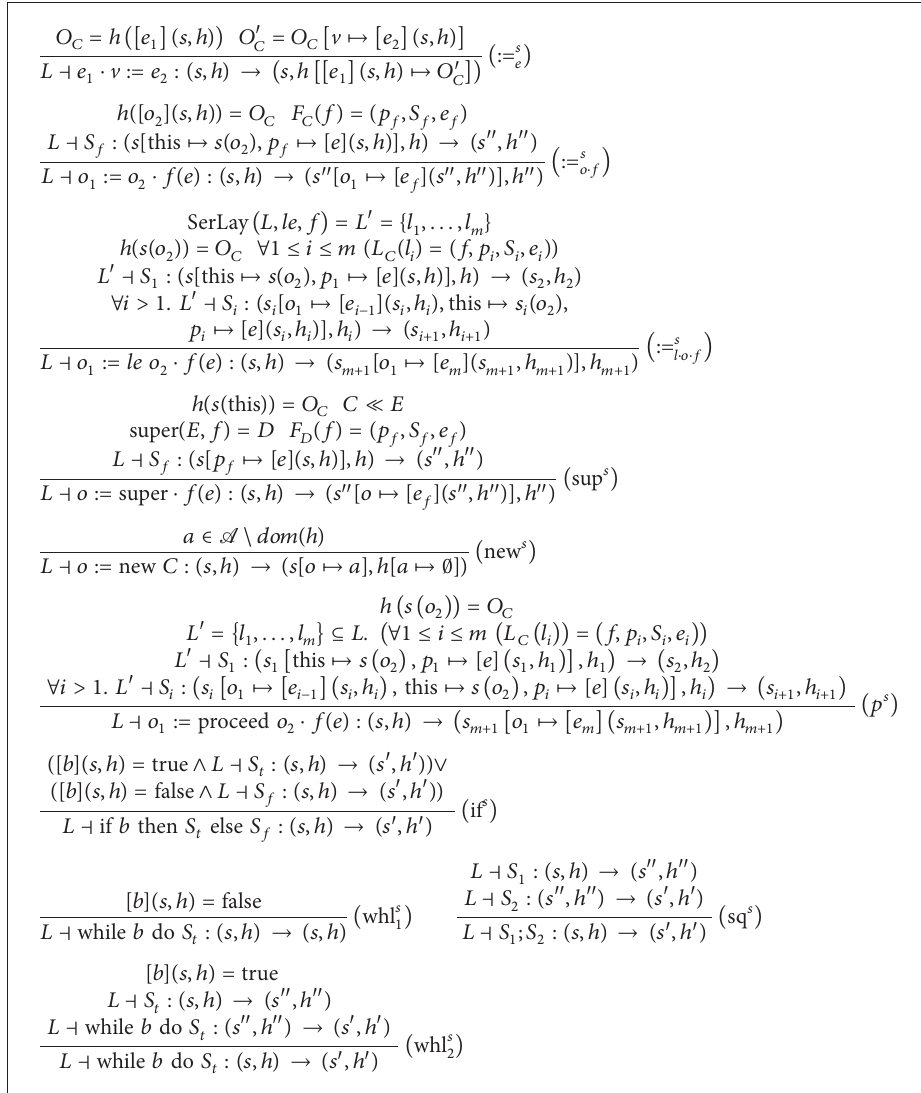
Algorithm 3: Inference rules of the operational semantics for J-COP